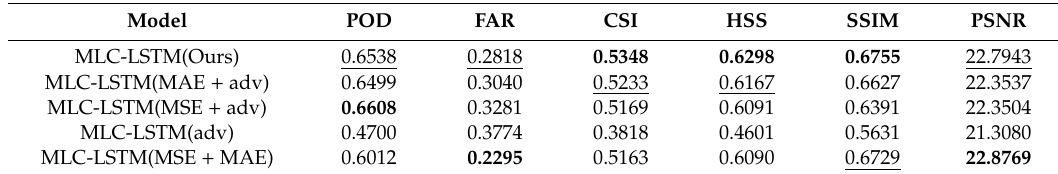
Table 4. Quantitative evaluation results on six metrics of Multi-Level Correlation Long Short-Term Memory (MLC-LSTM) trained with di ff erent loss schemes.